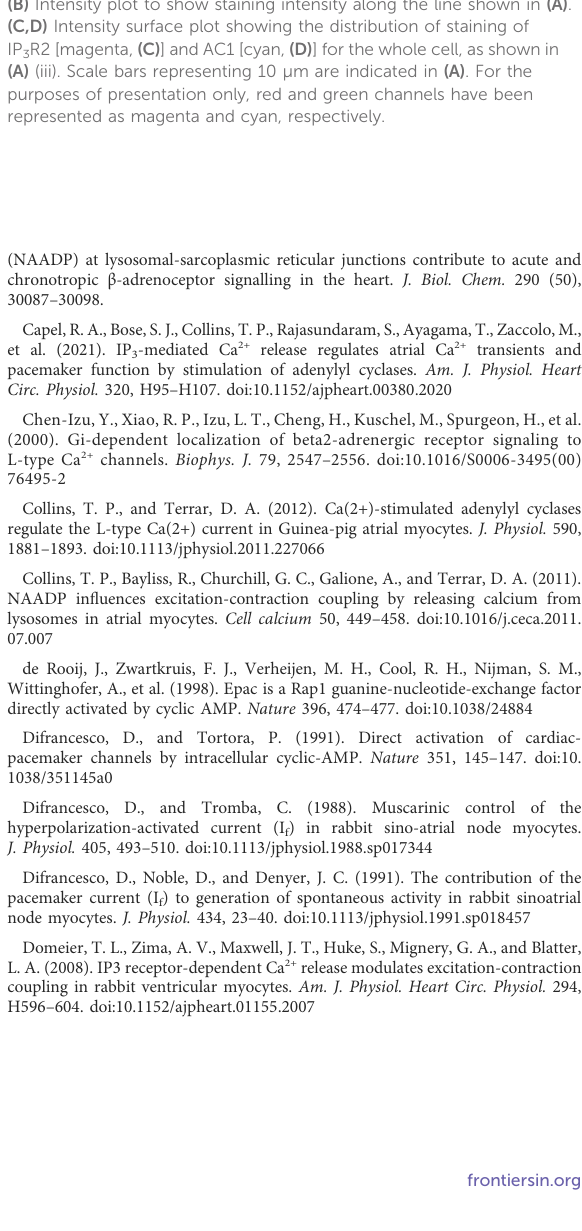
SUPPLEMENTARY FIGURE S1 Effect of different combinations of metoprolol (1 μ M), ST034307 (1 μ M) and PE (10 μ M) on mouse right atrial beating rate. Bars represent mean heart rate (bpm) under different conditions as indicated below the x-axis. Signi fi cance bars represent comparison of the data using ANOVA followed by Fisher ’ s LSD test to compare all conditions (non-signi fi cant comparisons are not shown) ( n = 11 – 14). Data are represented as mean ± SEM. SUPPLEMENTARY FIGURE S2 (A) Representativeexampleofa fi xed,isolatedguineapigatrialmyocyte(i) immunolabelled for IP 3 R2 (magenta), (ii) AC1 (cyan), (iii) co- immunolabelledforIP 3 R2(magenta)andAC1 (cyan)and(iv)bright fi eld. (B) Intensity plot to show staining intensity along the line shown in (A) . (C,D) Intensity surface plot showing the distribution of staining of IP 3 R2 [magenta, (C) ] and AC1 [cyan, (D) ] for the whole cell, as shown in (A) (iii). Scale bars representing 10 µm are indicated in (A) . For the purposes of presentation only, red and green channels have been represented as magenta and cyan,